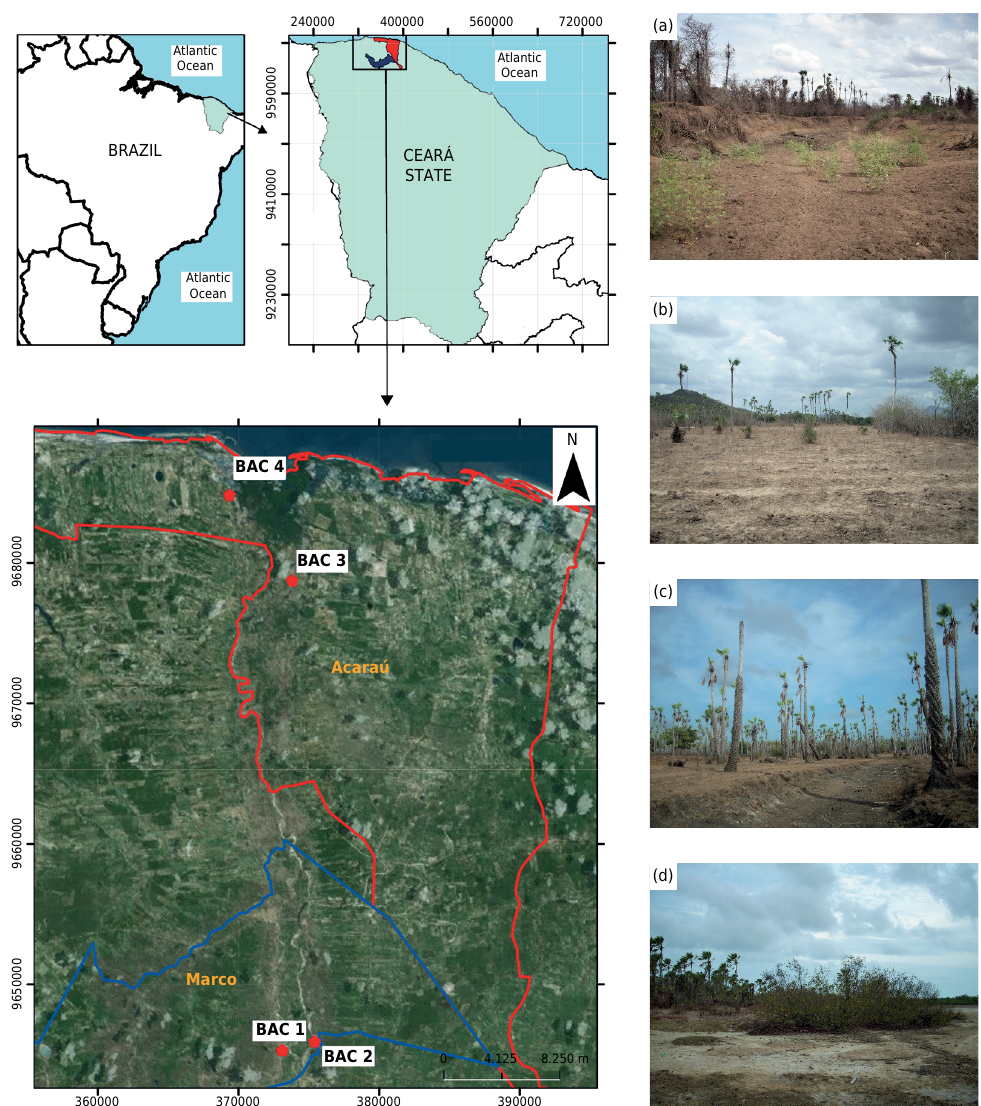
Figure 1. Scheme of location and situation of soil profiles (Zone 24; UTM coordinates). Environment of profile collection BAC1 [Eutric Sodic Fluvisol (Loamic)] (a); environment of profile collection BAC2 [Eutric Fluvic Planosol (Loamic)] (b); environment of profile collection BAC3 [Sodic Vertisol (Hypereutric)] (c); environment of profile collection BAC4 [Fluvic Sodic Gleyic Solonchak (Hypersalic, Loamic)] (d). Blue line marks the limit of the municipality of Marco and the red line the limit of Acaraú-CE. Image: Google Earth